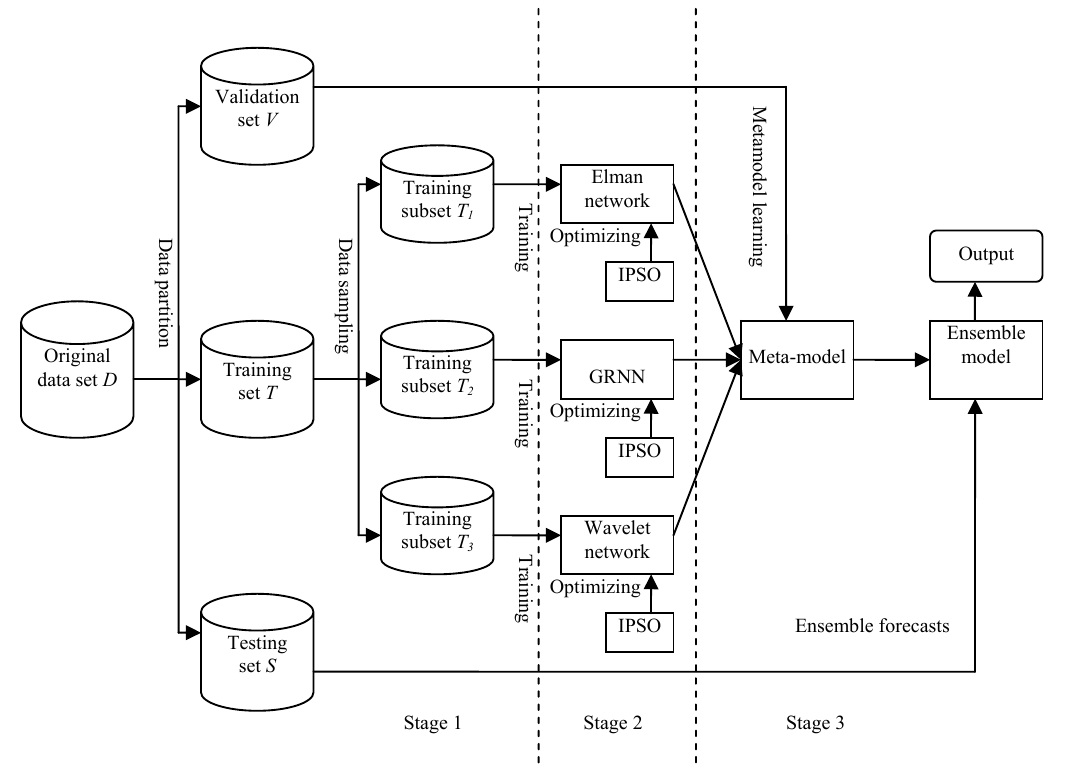
Fig. 1. A flow diagram of the nonlinear ensemble forecast